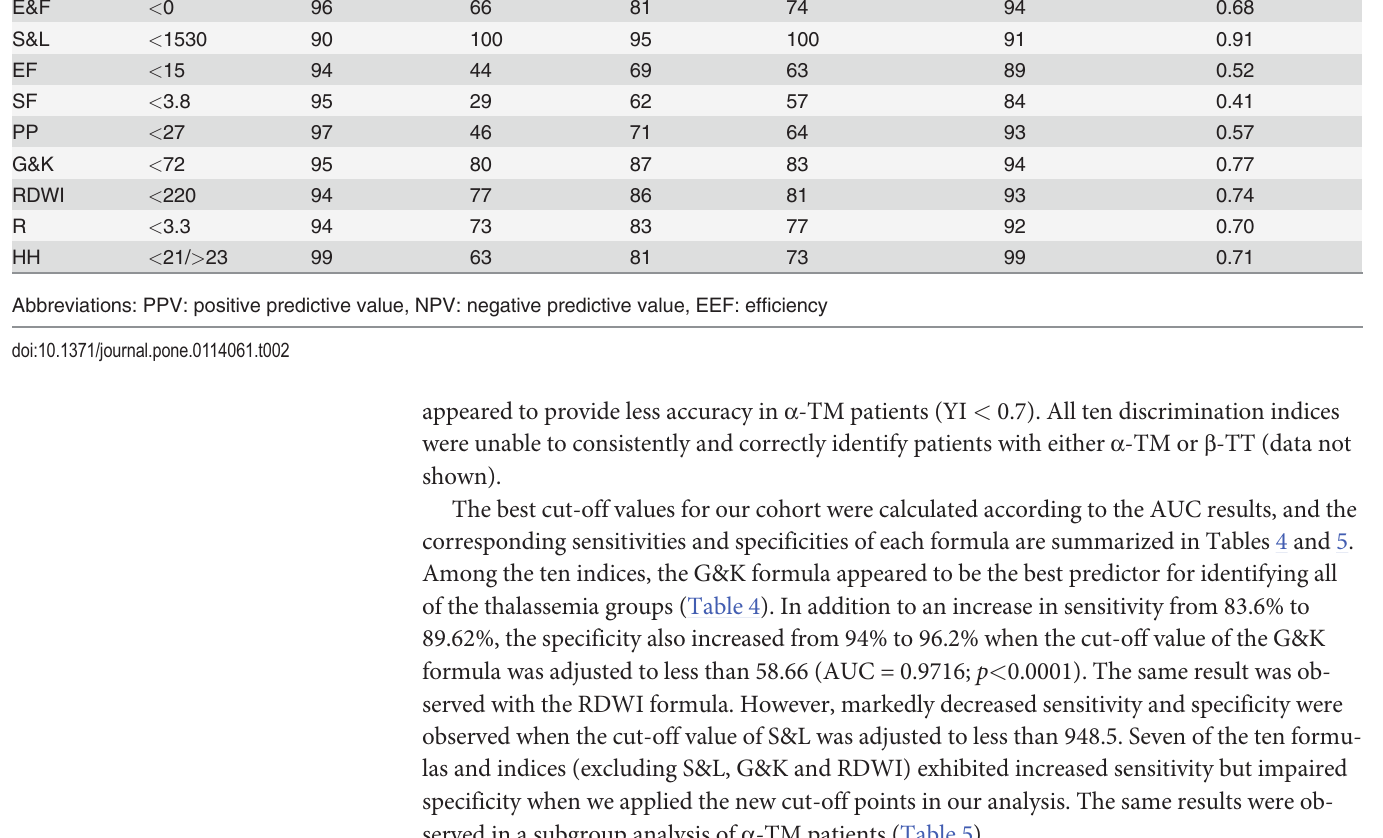
Table 2. The evaluation of different discrimination index in differentiation of thalassemia from IDA according to the previously published standard cut-off values. Cut-off